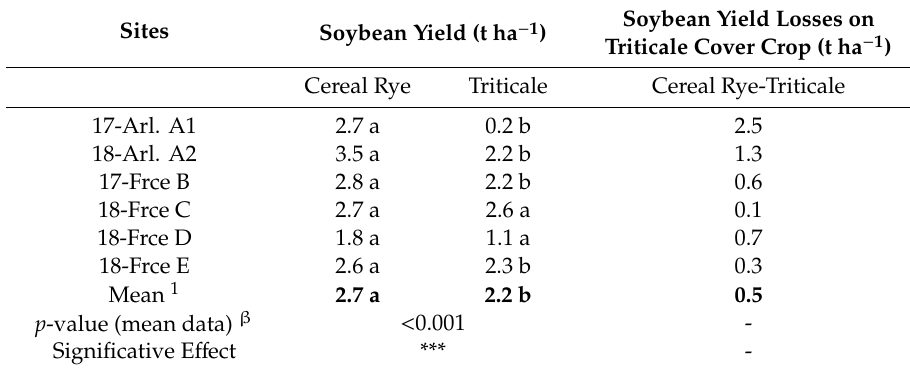
Figure 4. Soybean yields (t ha − 1 ) obtained from cereal rye and triticale cover crop treatments, averaged across all sites, 2017 and 2018, analyzed using linear mixed model ( P < 0.001, n = 144). Boxplots followed by the same letters are not significantly different. Table 4. Soybean yield (t ha − 1 ) averages per cover crop and per site, 2017 and 2018.